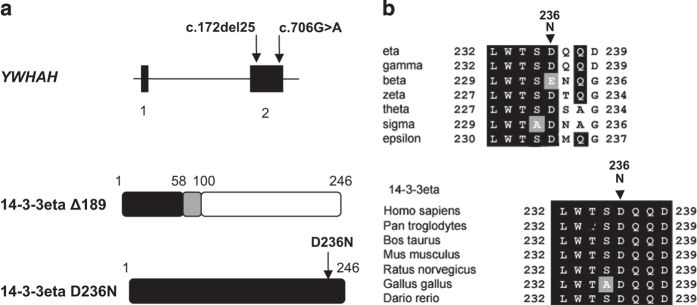
Identification of damaging variants in YWHAH gene. (a) Intron–exon structure of the YWHAH gene and position of variants in exon 2 (top). From top to bottom, schematic representation of the 14-3-3eta protein, position of variants and consequence of the deletion in protein translation (the gray box represents the frameshift, dotted lines represent truncative part of the protein). (b) Amino-acid alignment of the C-terminal domain of different 14-3-3 isoforms (top) and of 14-3-3eta from different species (bottom) showing the conserved aspartate at position 236. Conserved, semi-conserved and non-conserved substitutions are framed in black, gray and white boxes, respectively.